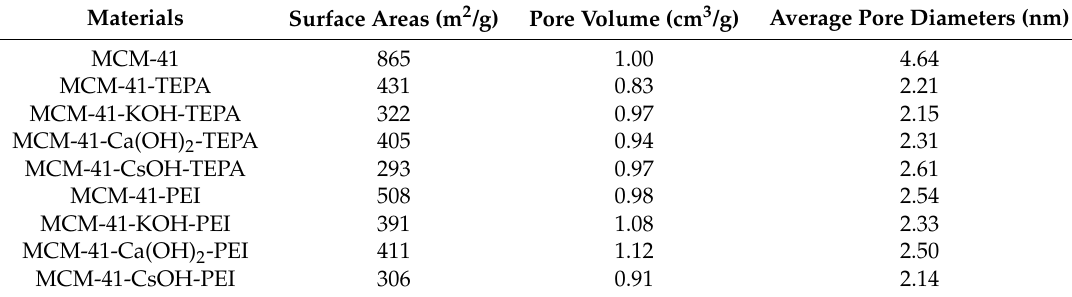
( b ) Figure 2. FT ‐ IR spectra of MCM ‐ 41 modified by ( a ) TEPA ( b ) PEI and various alkali components.